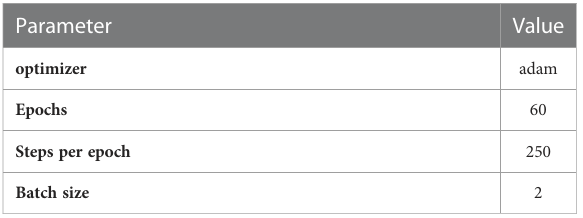
TABLE 1 The parameter settings of training